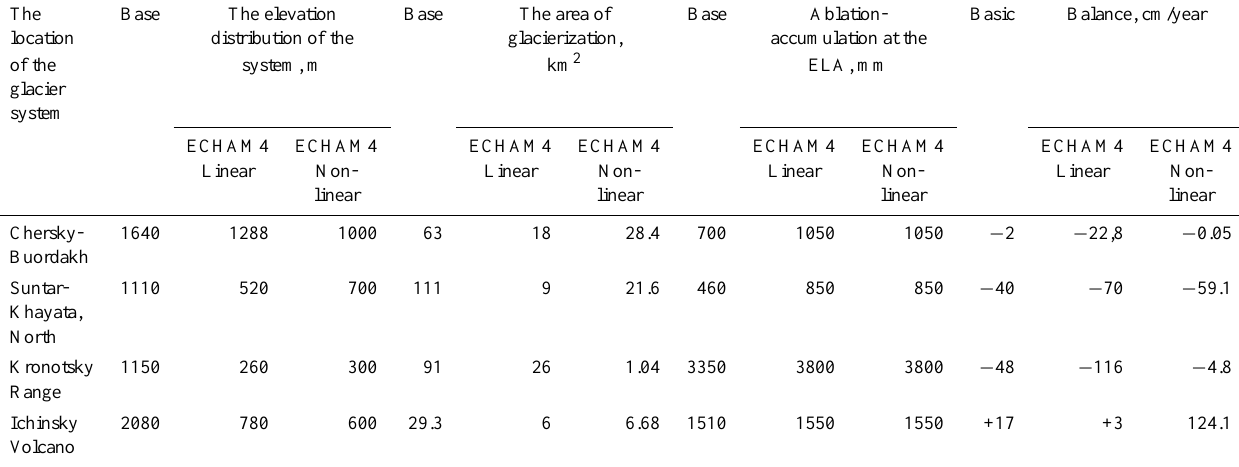
The Base The elevation Base The area of Base Ablation- Basic Balance, cm/year location distribution of the glacierization, accumulation at the of the system, m km 2 ELA, mm glacier